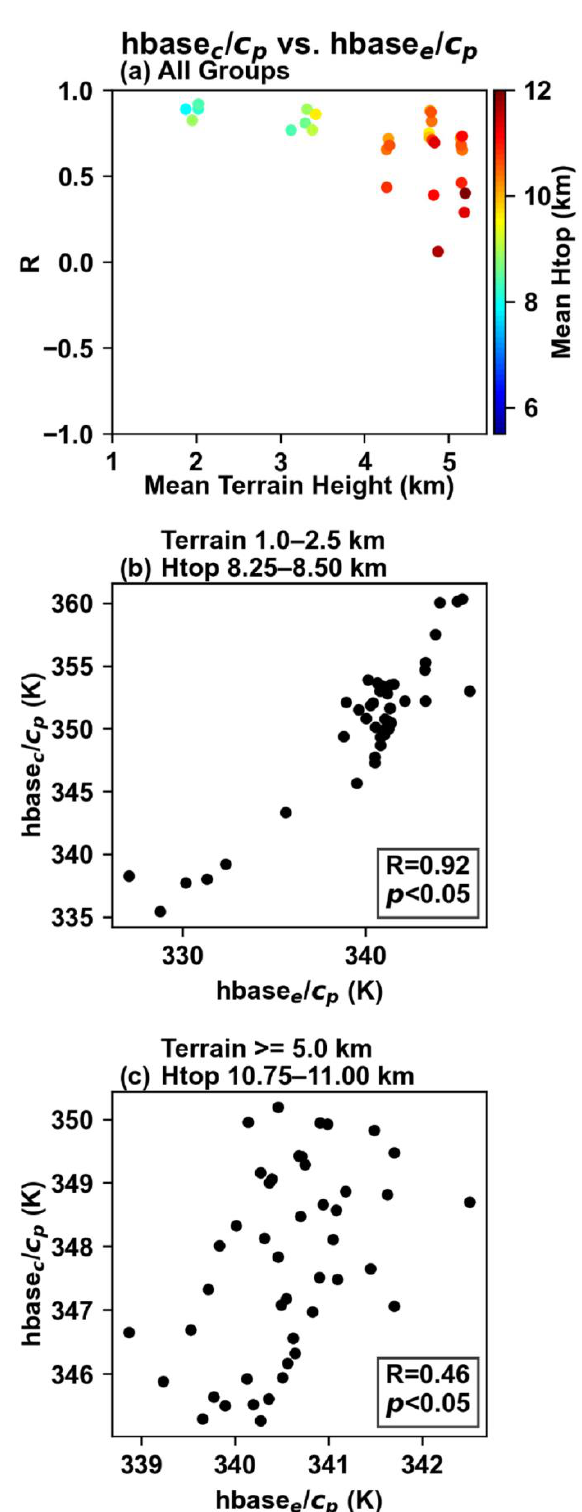
Figure 8. The correlation coefficients (R) of cloud base in-cloud moist static energy (represented as hbase c / c p ; units: K; c p is the isobaric specific heat of dry air) and cloud base environmental moist static energy (represented as hbase e / c p ; units: K) in different cloud groups in the studied region above 1 km terrain height (Panel a ), and the relationship between the hbase c / c p and hbase e / c p in the representative cloud groups (Panels b , c ); the color bar denotes the mean cloud top height in each group.